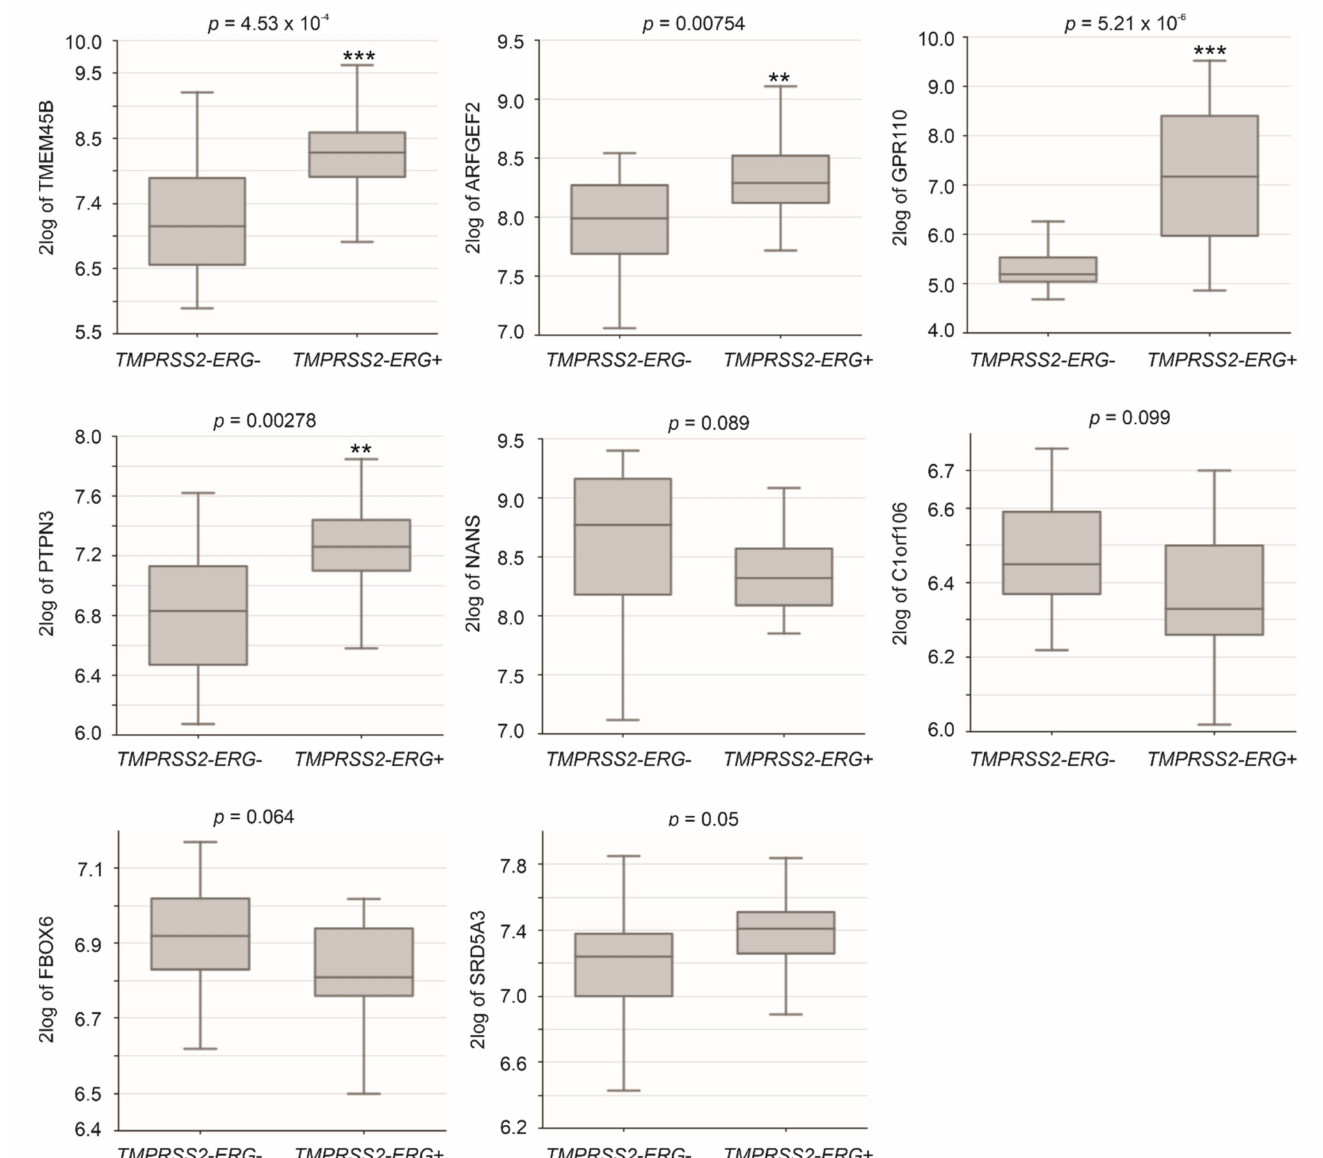
Figure 4. Differential expression of LE genes in PCs with TMPRSS2-ERG fusion. Analyses were performed using the Sueltman dataset in R2: Genomics Analysis and Visualization Platform. Expressions were presented as log2-transformed data. Statistical analyses were performed by the R2 Platform using one-way ANOVA. ** p < 0.01; *** p <